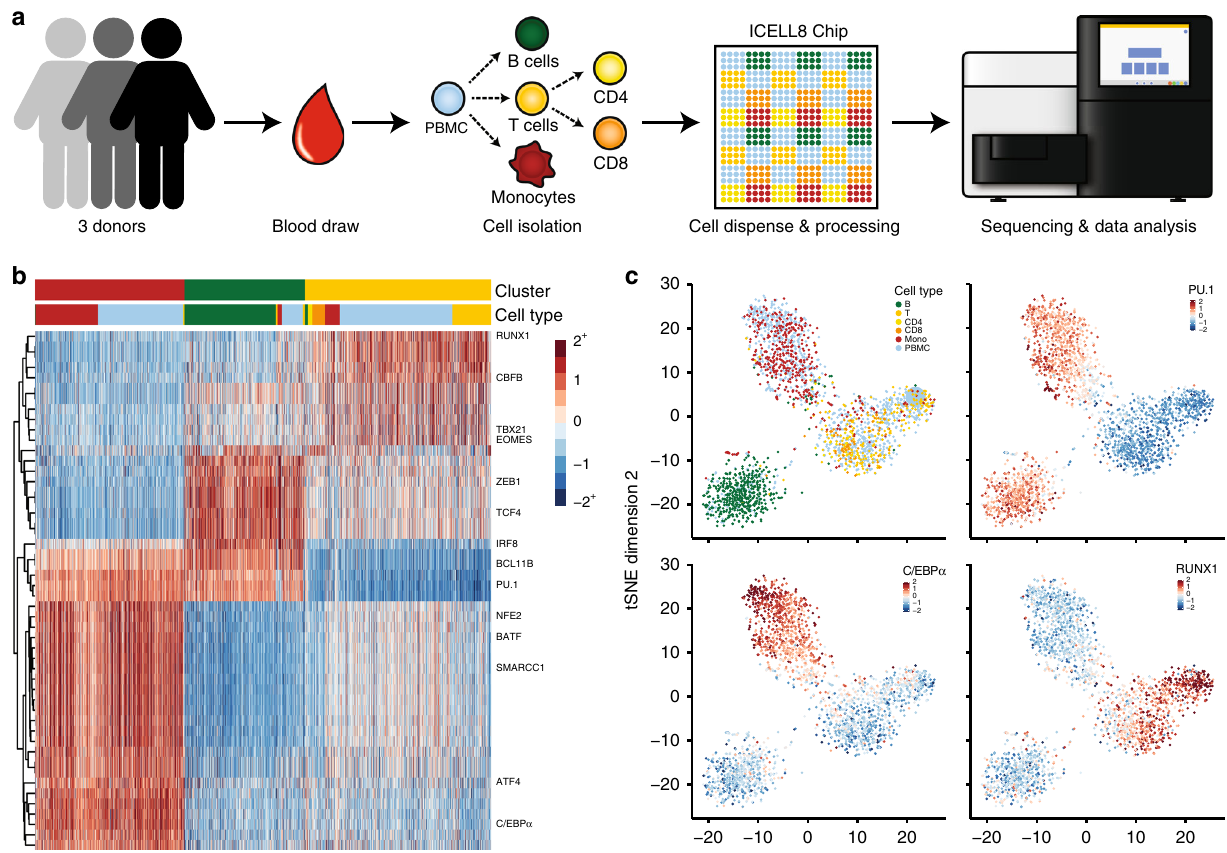
Fig. 2 De novo identi fi cation of hematopoietic cell types by µ ATAC-seq. a Human PBMC isolation and µ ATAC-seq work fl ow. b Hierarchical (TF motifs) and k-means (cells) clustering of accessibility deviation z -scores across 2333 single cells (columns) of the 50 most variable TF motifs (rows). Colors correspond to cell types de fi ned in a . c tSNE visualization of accessibility deviations at TF motifs for cells in b . Cells are either colored by cell type (upper left panel) or by the accessibility deviation z -score for the speci fi ed TF